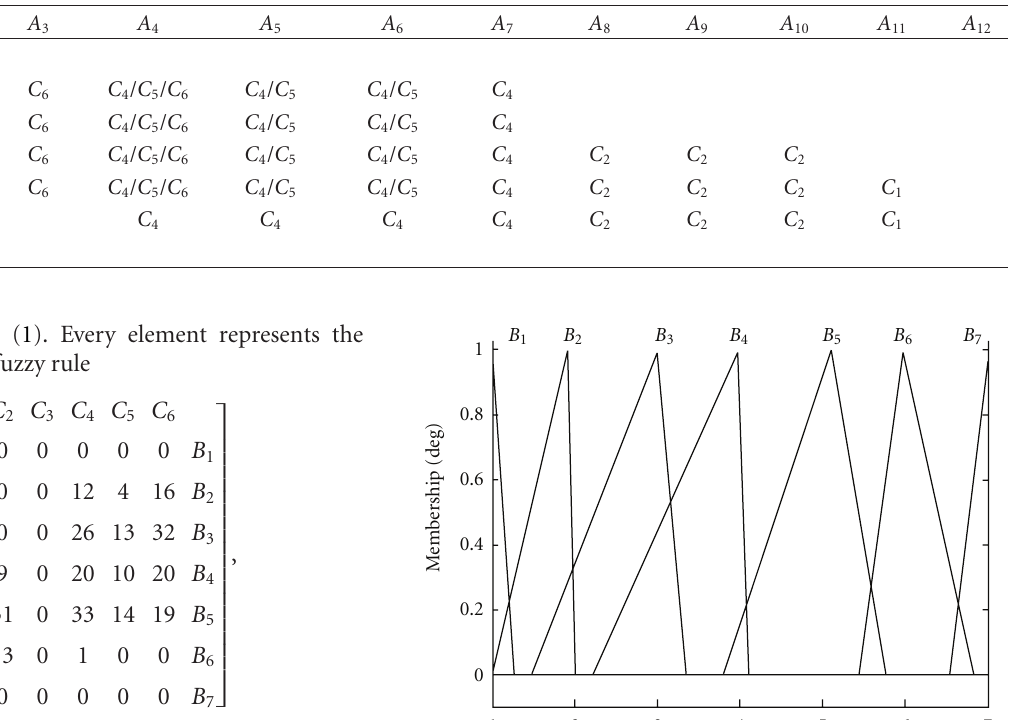
Table 4: Initial fuzzy rules.